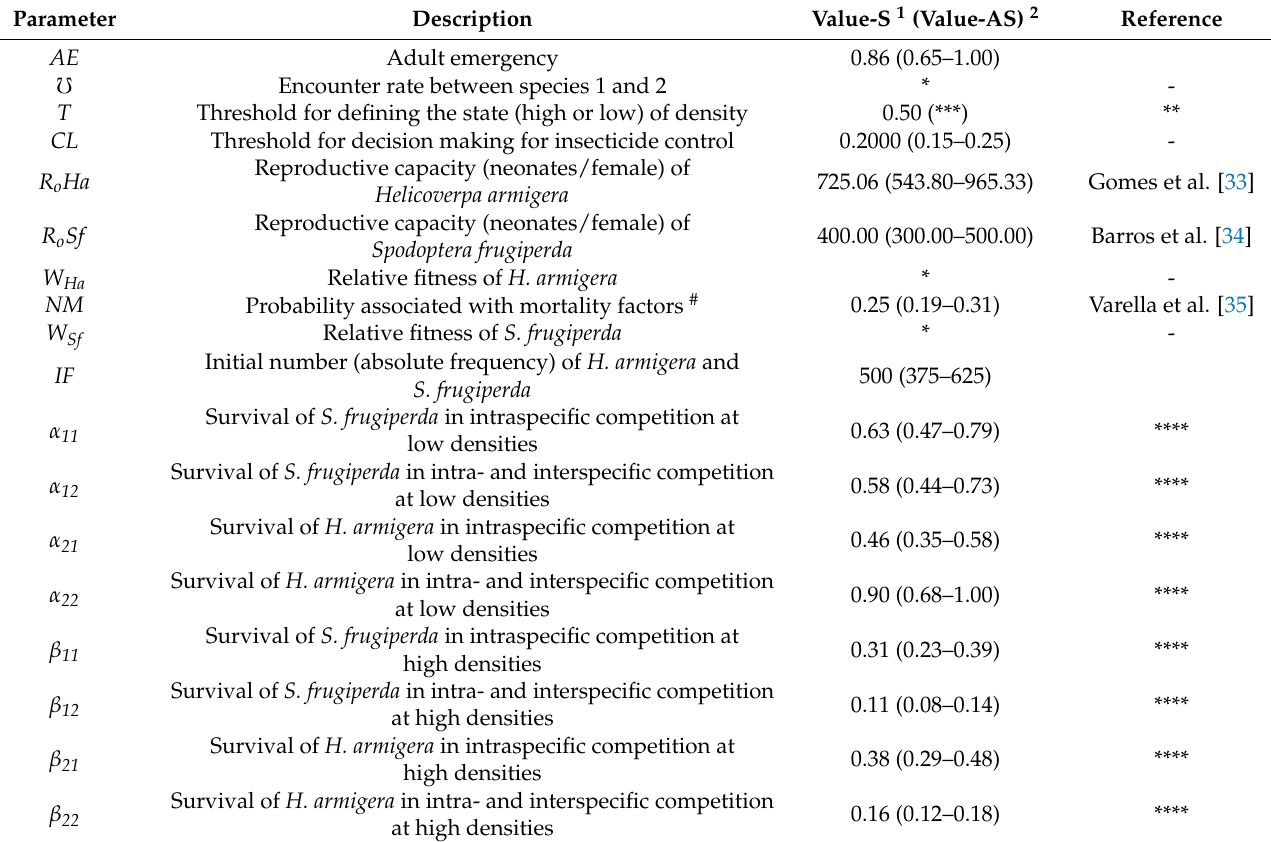
Table 1. Description values and parameters used in the simulations (S) of the model and in the sensitivity analysis (SA).